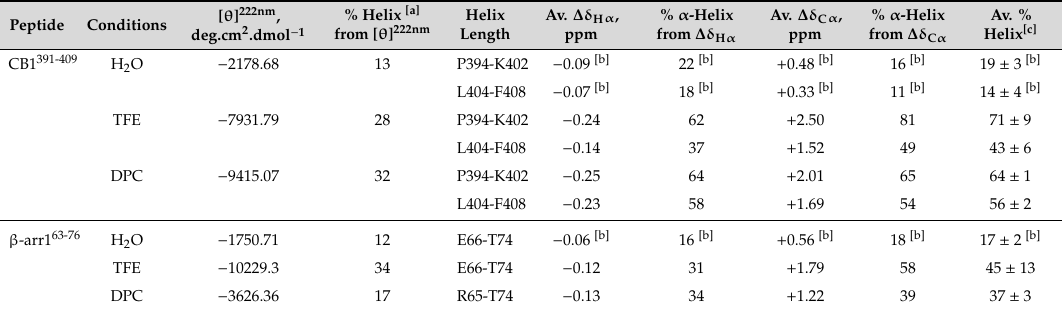
and Δδ C α values.